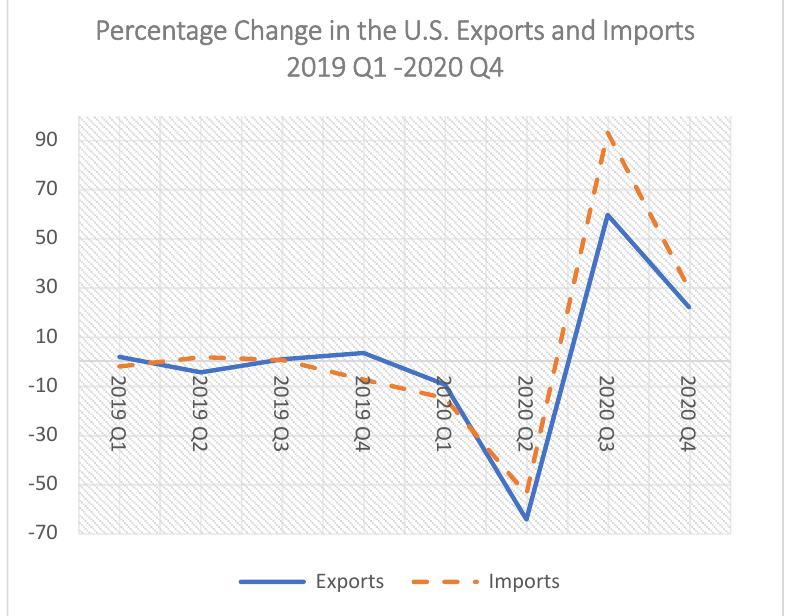
Figure 6. Percentage Change in the U.S. Exports and Imports, 2019 Q1–2020 Q4 Data source: U.S. Bureau of Economic Analysis.